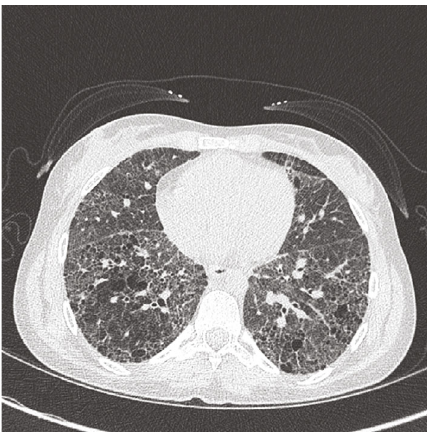
Figure 1: Chest computed tomography of the patient ’ s native lungs demonstrating cystic changes, di ff use coarse reticular interstitial thickening with associated ground glass opacities.